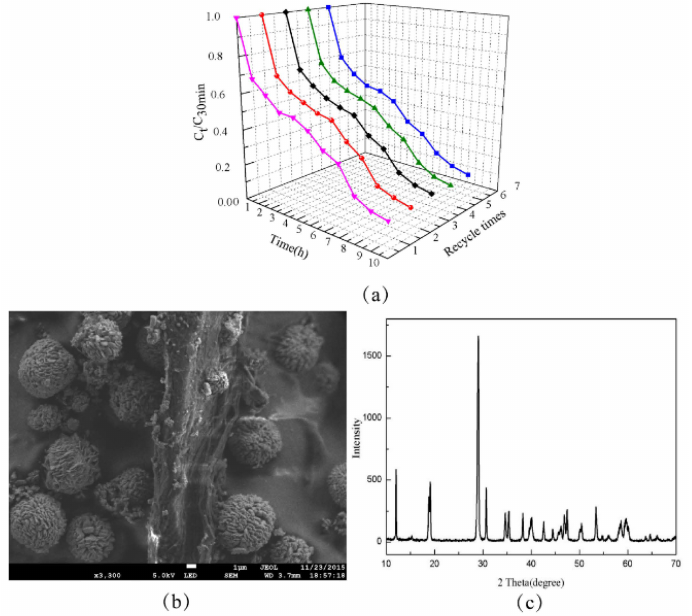
Figure 10. ( a ) Cycling runs of photocatalytic degradation of RhB over AgGB-0.5 photocatalyst; ( b ) SEM image of AgGB after five rounds of cycling; and ( c ) XRD patterns of AgGB-0.5 composite after five rounds of